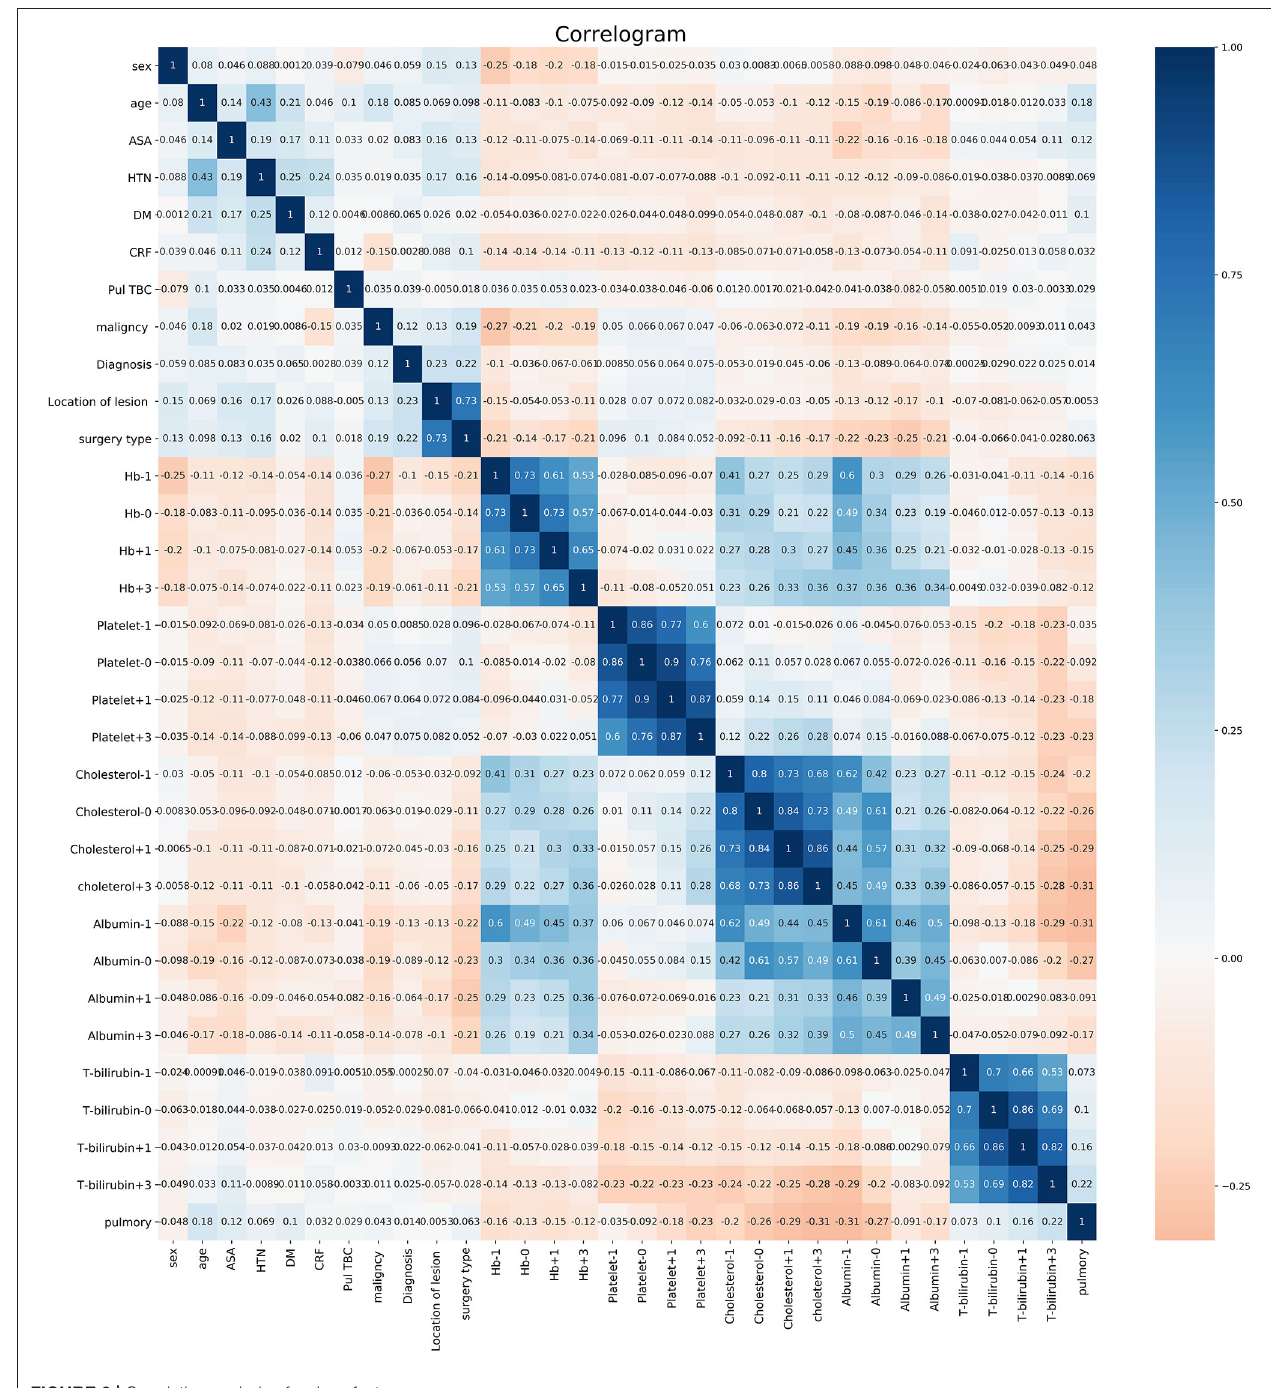
also shows that perioperative platelet changes are a factor in the occurrence of